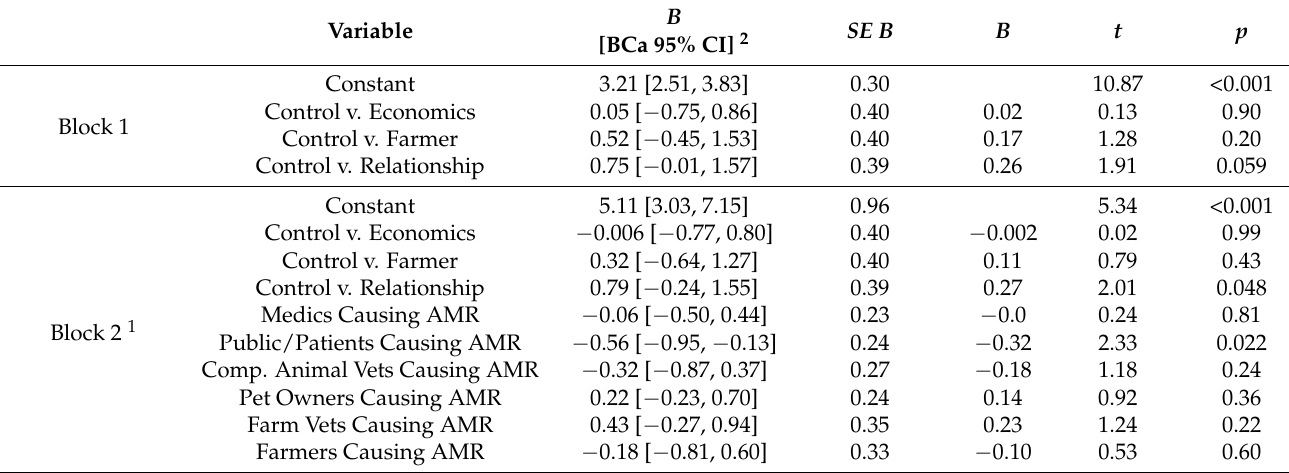
Table 4. Hierarchical Regression Model for Beliefs about Responsibility for Causing AMR as Predictors of Prescribing. Variable